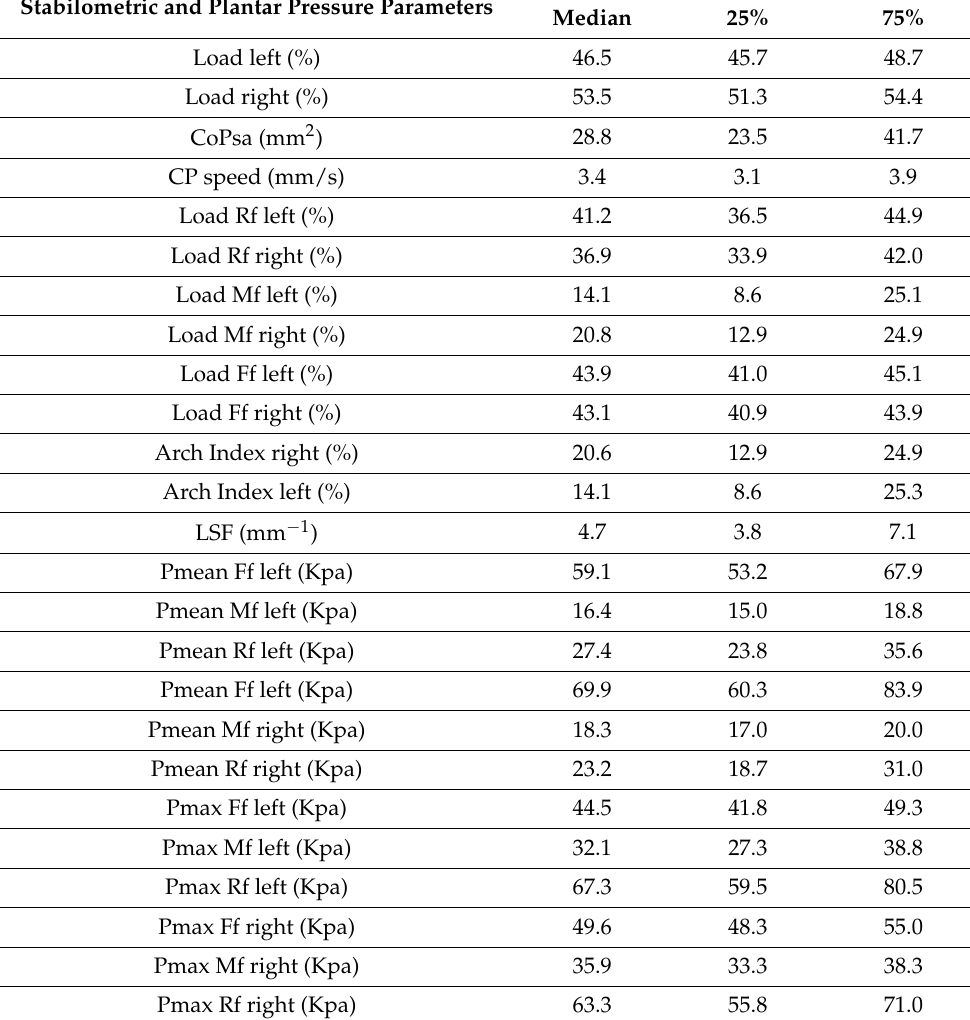
Table 2. Normative values for all baropodometric parameters reported as inter-subject median (25% 75%). Not significant (NS); forefoot (Ff); midfoot (Mf); rearfoot (Rf); mean pressure (Pmean); maximum pressure (Pmax); center-of-pressure speed (CP speed); center-of-pressure sway area (CoPsa); length surface function (LSF). Stabilometric and Plantar Pressure